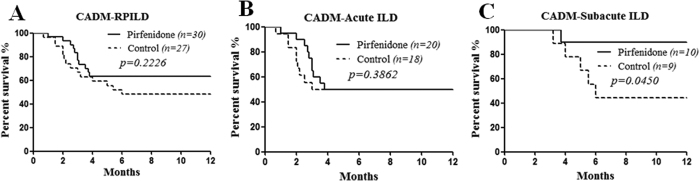
The survival curves of the pirfenidone add-on group and the control group.(A) Survival analysis of all patients showed that the pirfenidone add-on group had fewer deaths than the control group, but the difference was not significant. (B) The pirfenidone add-on had no impact on the survival of patients with acute ILD (disease duration <3 months). (C) The pirfenidone add-on led to a significantly higher survival rate in subacute ILD patients (disease duration 3–6 months) compared with the control subgroup.